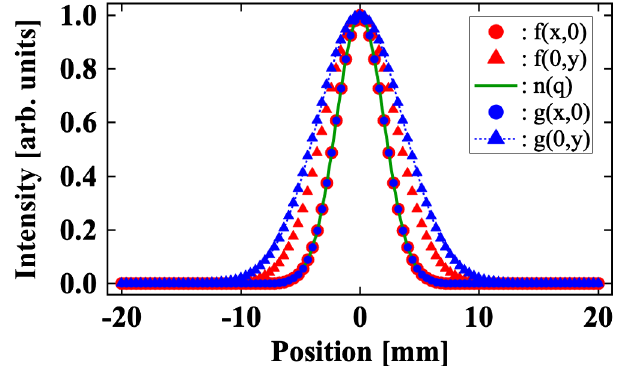
FIG. 5. Estimations of the beam profiles expected to be measured using the gas sheet monitor with typical parameters of the J-PARC beam profile and the gas density spatial distri- bution. The center position of the beam is ð x; y Þ ¼ ð 0 ; 0 Þ . The beam distribution is approximated as Gaussian distributions σ ¼ 2 mm, σ ¼ 3 mm, and the gas distribution is also ap- x y ¼ 2 proximated as a Gaussian distribution σ n